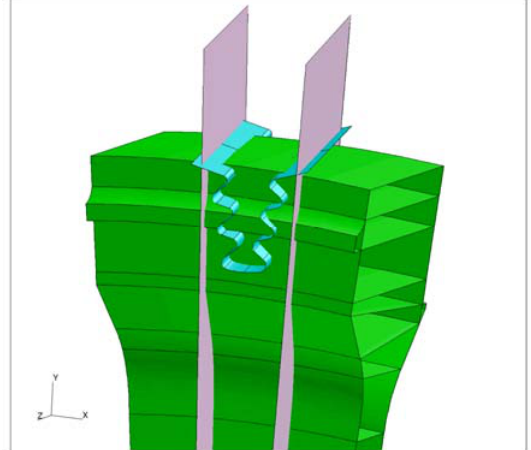
Fig 4. Border surfaces of disc used to create the model of